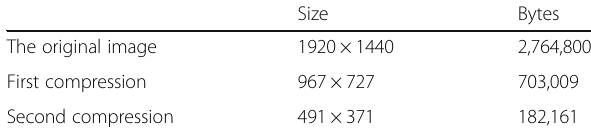
Table 1 Image properties after